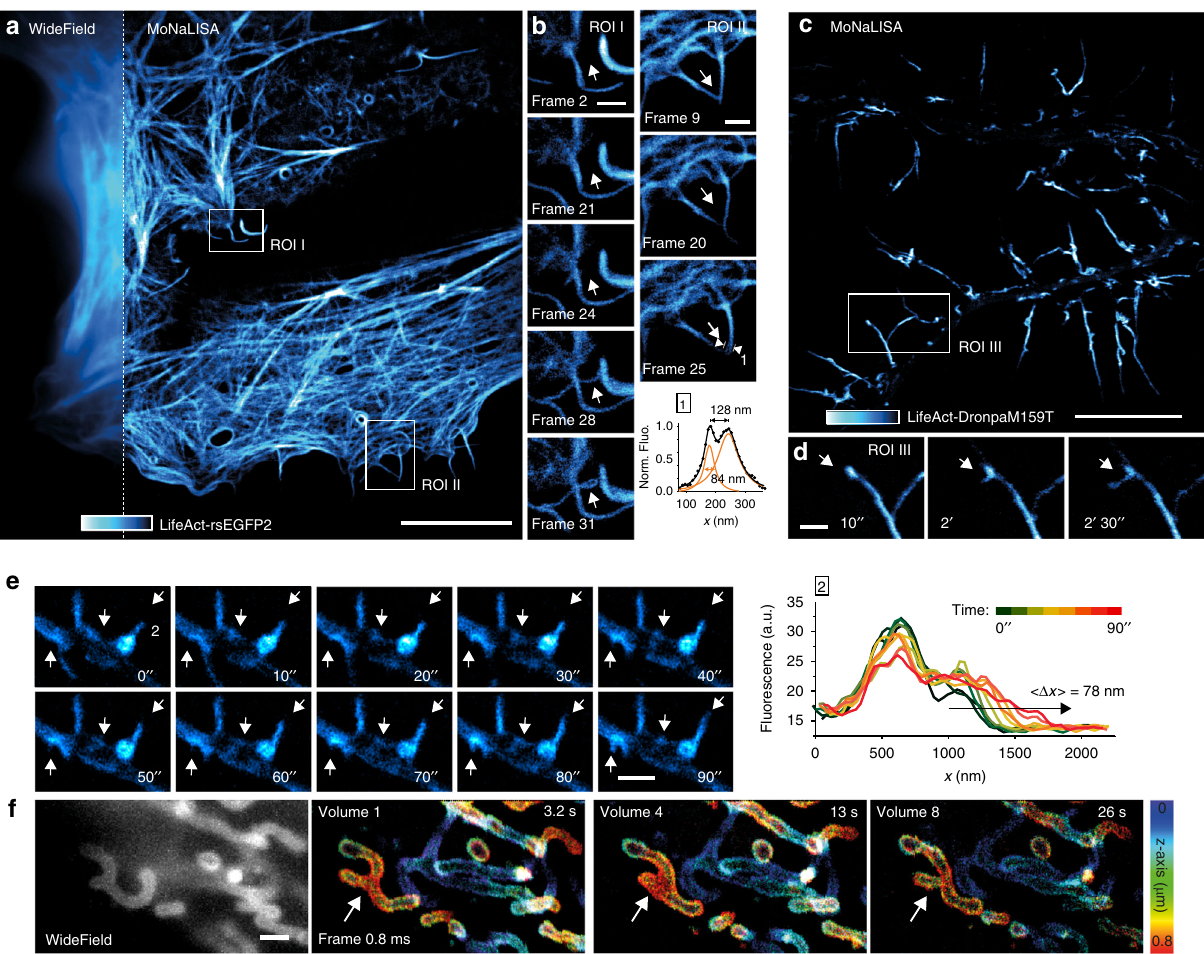
Fig. 4 MoNaLISA time-lapse imaging. a Nanoscale imaging of epithelial cells expressing LifeAct-rsEGFP2 compared to the wide- fi eld image (inset). Scale bar, 10 μ m. b Magni fi ed regions I and II unravel the dynamics of growing small fi lopodia observed over 3 min for a total of 45 frames, each acquired in 3.9 s. Scale bar, 1 μ m. c Living hippocampal neurons infected with LifeAct-DronpaM159T showing the actin arrangements in dendrites and dendritic spines. Scale bar, 10 μ m. d Magni fi ed region III highlights the recruitment of actin molecules into a spine, which slowly enlarge its head into a cup-shape across 19 frames (left arrow), each acquired in 3.4 s. Scale bar, 1 μ m. e Dynamics of dendritic fi lopodia emerging from actin densities in the dendritic shaft in neuron at 8 DIV. The arrows highlight the actin dynamics and redistribution. The graph shows the elongation over time of the fi lopodia 2 and reveals nanosized increments across time. Each line pro fi le was averaged over a 100 nm width. f Nanoscale imaging of the mitochondria outer membrane labeled with rsEGFP2-Omp25. The mitochondrial volumetric dynamics are recorded continuously over seconds. The axial information is color-coded. Single frame recording 0.83